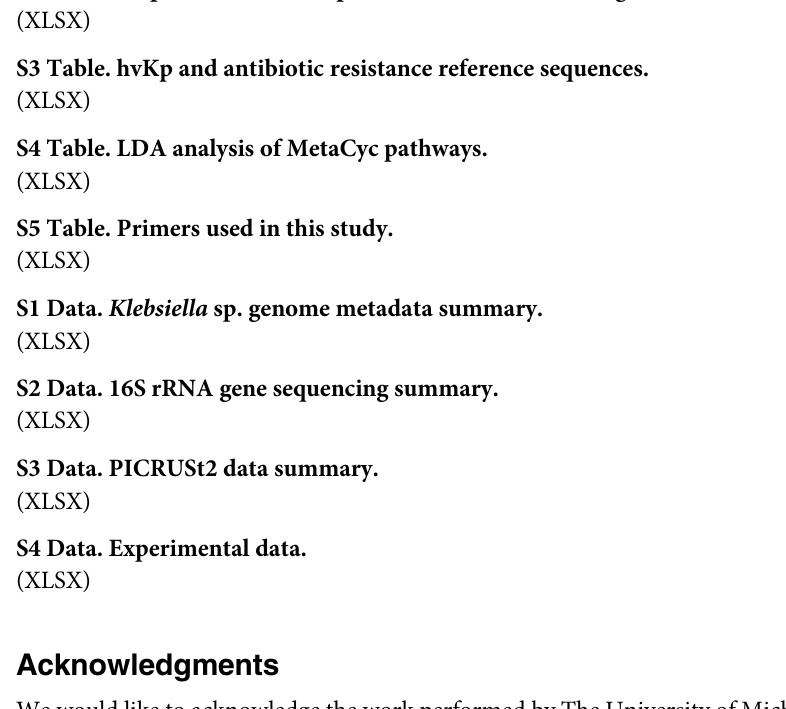
S1 Table. Conservation and function of ter locus and neighboring genes. S2 Table. ter plasmids and hvKp and antibiotic resistance gene characterization. S3 Table. hvKp and antibiotic resistance reference sequences. S4 Table. LDA analysis of MetaCyc pathways. S5 Table. Primers used in this